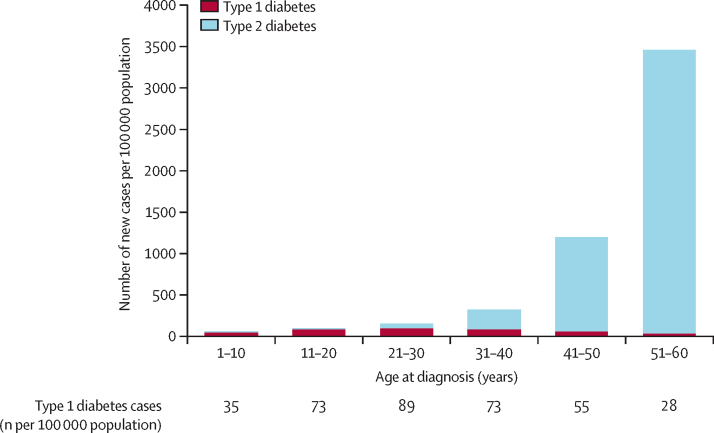
Incidence of genetically defined type 1 and type 2 diabetes in the first six decades of lifeCases of type 1 diabetes were distributed across all ages of diagnosis, whereas cases of type 2 diabetes increased substantially with increasing age.